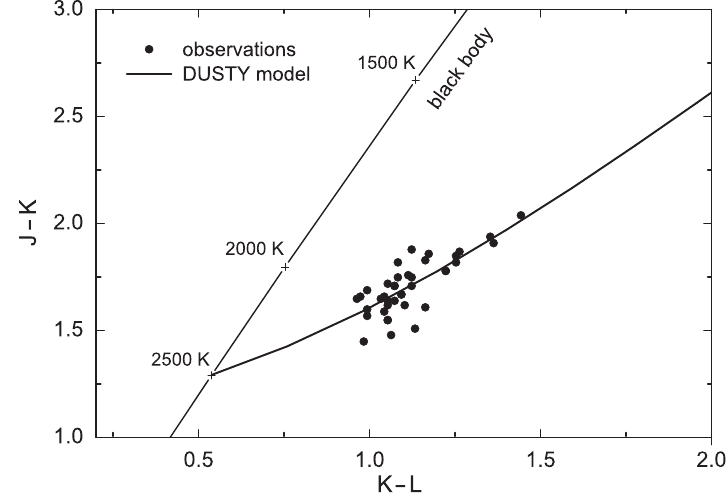
Fig. 3. Two-color JKL diagram of RR Tel used to determine long-term dust properties. The best (cid:12)t theoretical model and the blackbody line are shown. The model parameters are given in Table